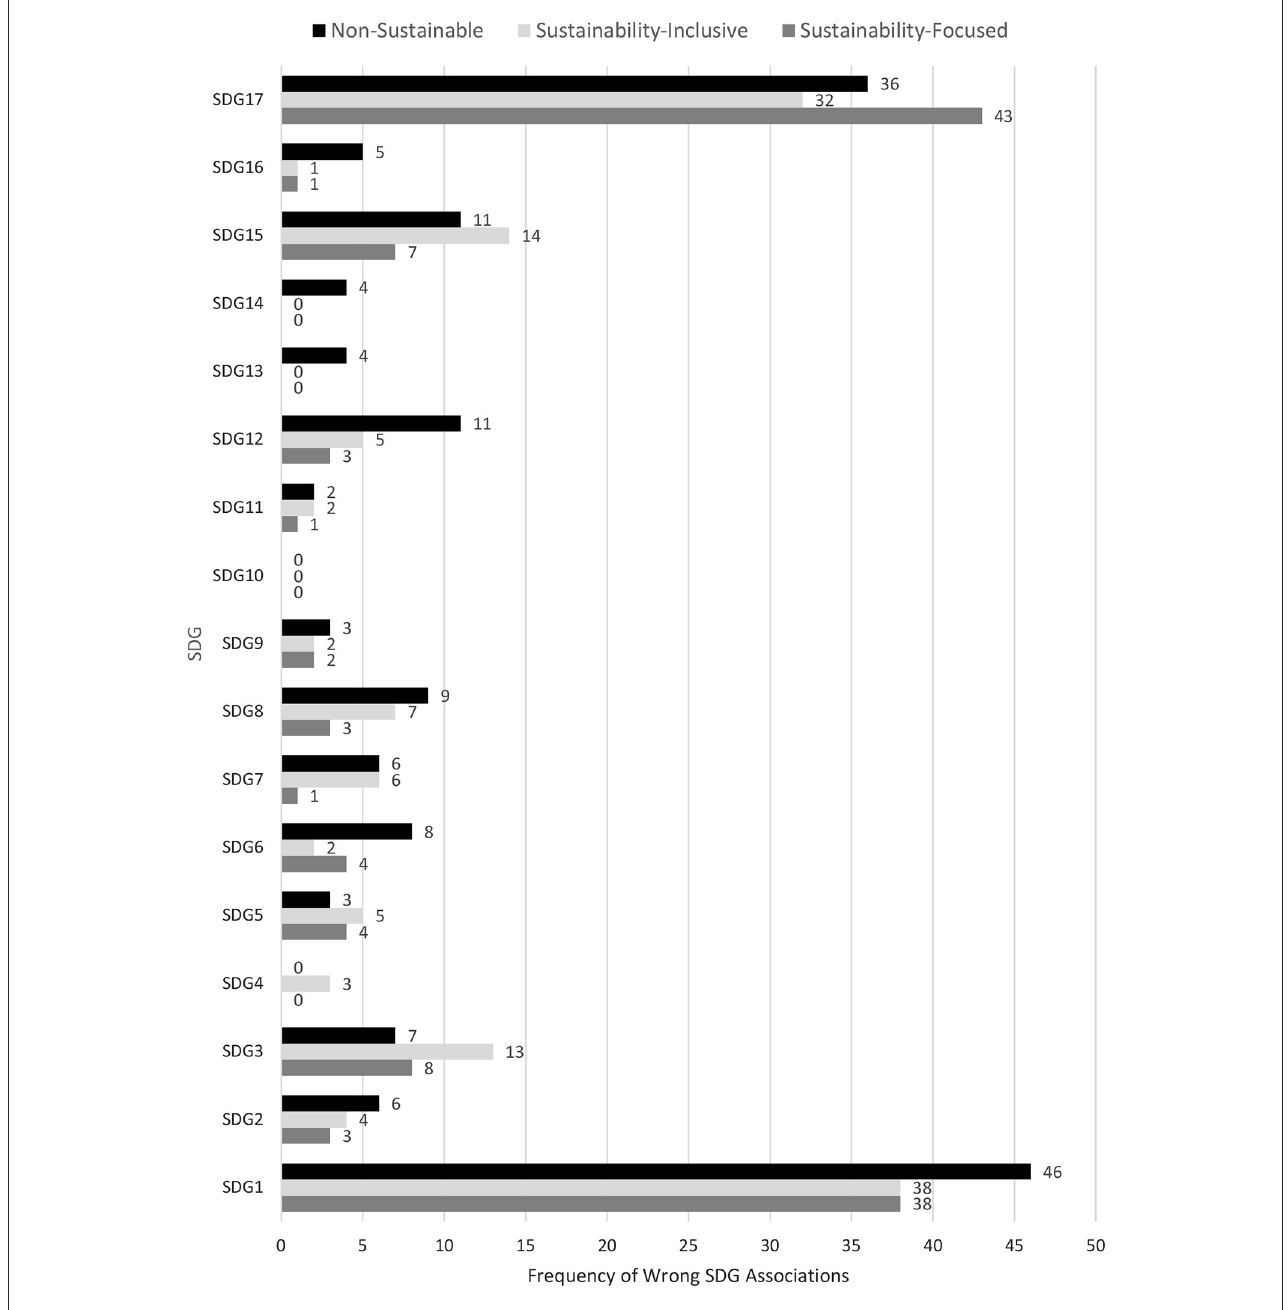
FIGURE7 Overall frequencies of wrong SDG associations for all categories.